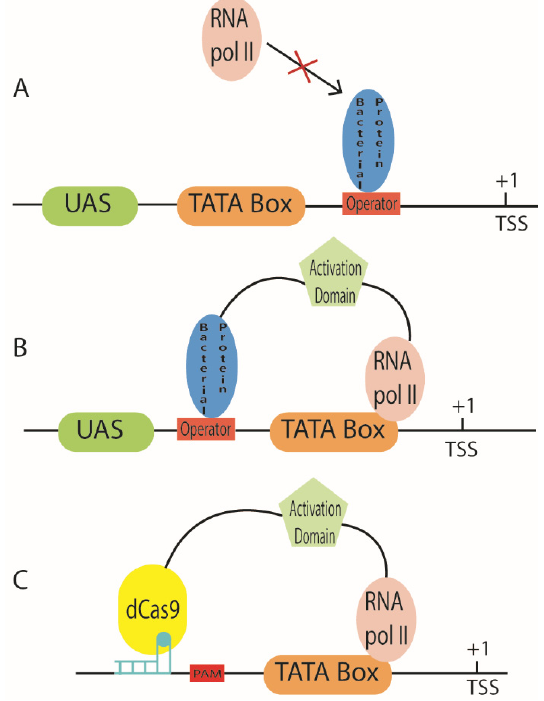
Figure 5. Promoters regulated by bacterial proteins. ( A ) Repressed promoters demand to place the operator of a bacterial protein between the TATA box and the TSS. ( B ) To build activated promoters, operators shall be placed upstream of the TATA box. Moreover, a bacterial protein behaves as a yeast activator upon fusion to an activation domain. ( C ) The CRISPR-dCas9 system can be used to either activate (as in the figure) or repress transcription. The sgRNA binds a complementary sequence, along the promoter, that is followed by a protospacer adjacent motif (PAM).